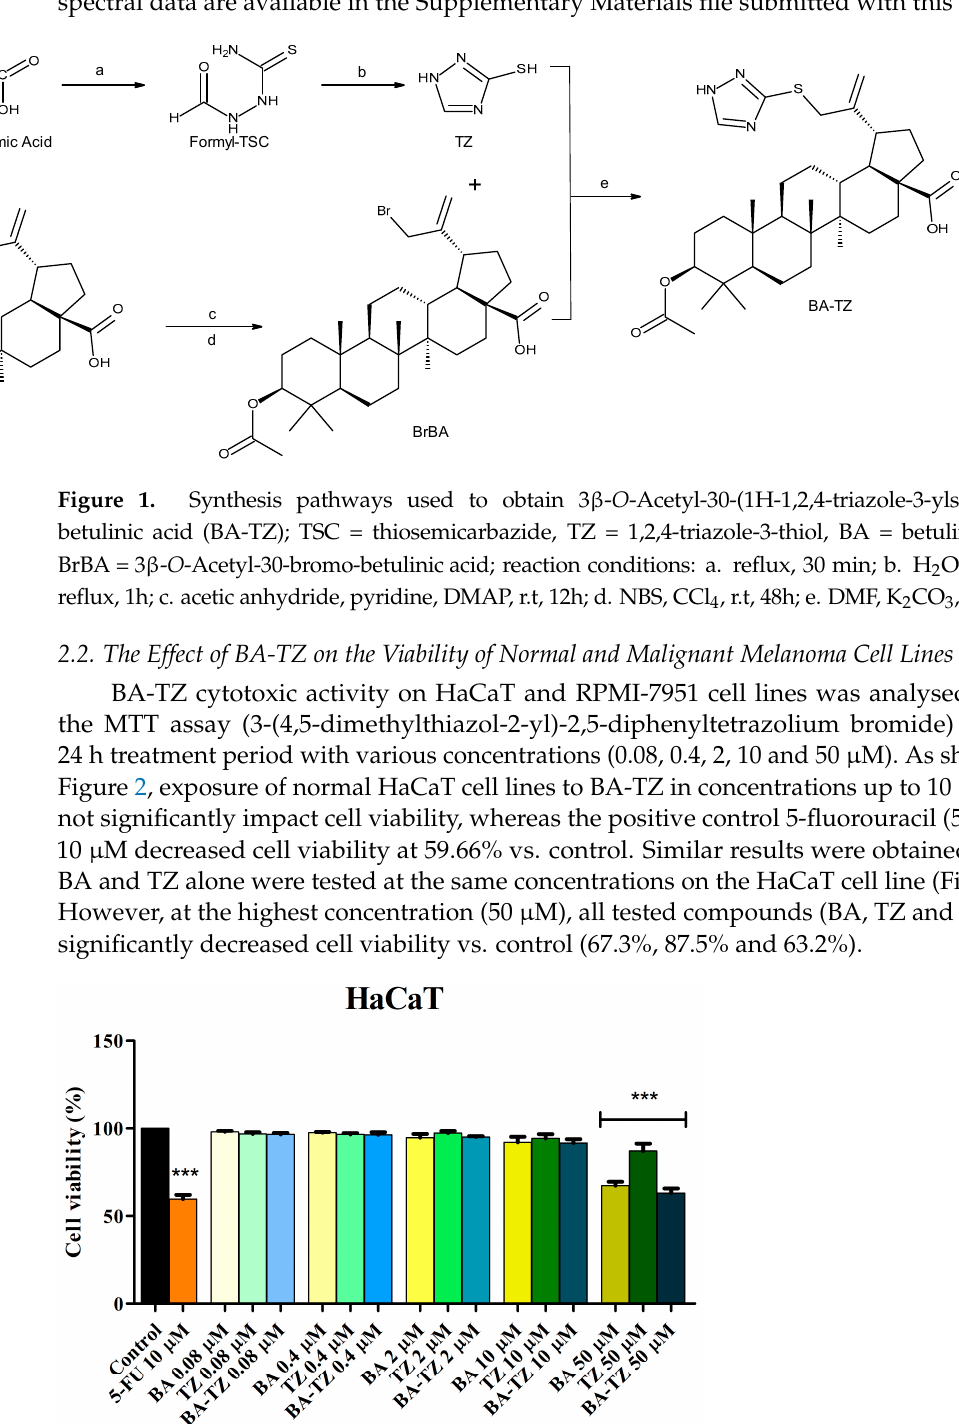
Figure 2. Cell viability of HaCaT cells after 24 h treatment with BA-TZ 0.08, 0.4, 2, 10 and 50 µ M, determined using the MTT assay. Untreated cells were used as the negative control, whereas 5-FU was used as the positive control. The results are expressed as cell viability percentage (%) normalized to the negative control (100%). The data represent the mean values ± SD of three independent experiments performed in triplicate. The statistical differences vs. the negative control was determined using two-way ANOVA analysis followed by Bonferroni’s multiple comparisons post-test (*** p < 0.0001). In the malignant melanoma RPMI-7951 cell line, BA-TZ at concentrations of 2, 10 and 50 μΜ significantly decreased cell viability to 88.3%, 54.7% and 24.5%, as compared to the negative control (100%). At the same time, 5-FU, at the tested concentration (10 μΜ ), de- creased cell viability down to 32%. (Figure 3). Significant decreases in cell viability were also obtained when BA and TZ were tested alone at the same concentrations, but both to a lesser degree compared with BA-TZ. Against the negative control, BA decreased cell viability to 89.1%, 65.1% and 31.3% when tested at 2, 10 and 50 μΜ , whereas TZ only to 89.9%, 80.2% and 57.4% (Figure 2). Figure 3. Cell viability of RPMI-7951 cells after 24 h treatment with BA-TZ 0.08, 0.4, 2, 10 and 50 μ M, determined using the MTT assay. Untreated cells were used as negative control, while 5-FU was used as positive control. The results are expressed as cell viability percentage (%) normalized to the negative control (100%). The data represent the mean values ± SD of three independent ex- periments performed in triplicate. The statistical differences vs. the negative control was determined